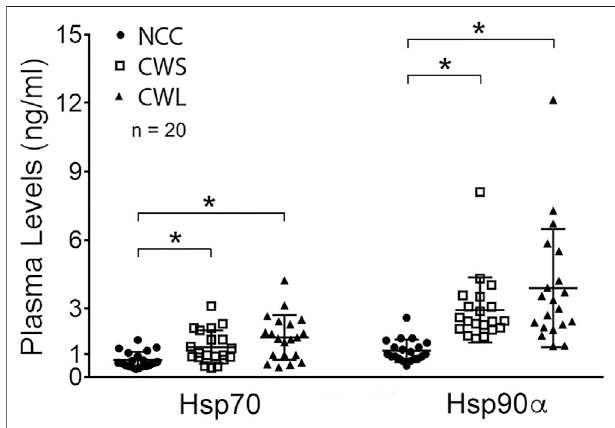
FIGURE 4 | Higher levels of plasma Hsp70 and Hsp90 α in cancer patients. Patient plasma Hsp70 and Hsp90 α levels were determined by